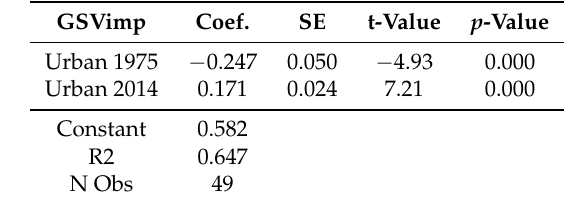
Table 4. GSV-impoverished and urbanized areas in